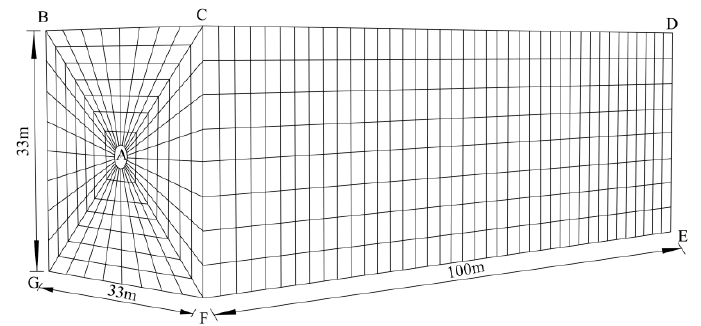
Figure 4. 3D model meshing diagram.